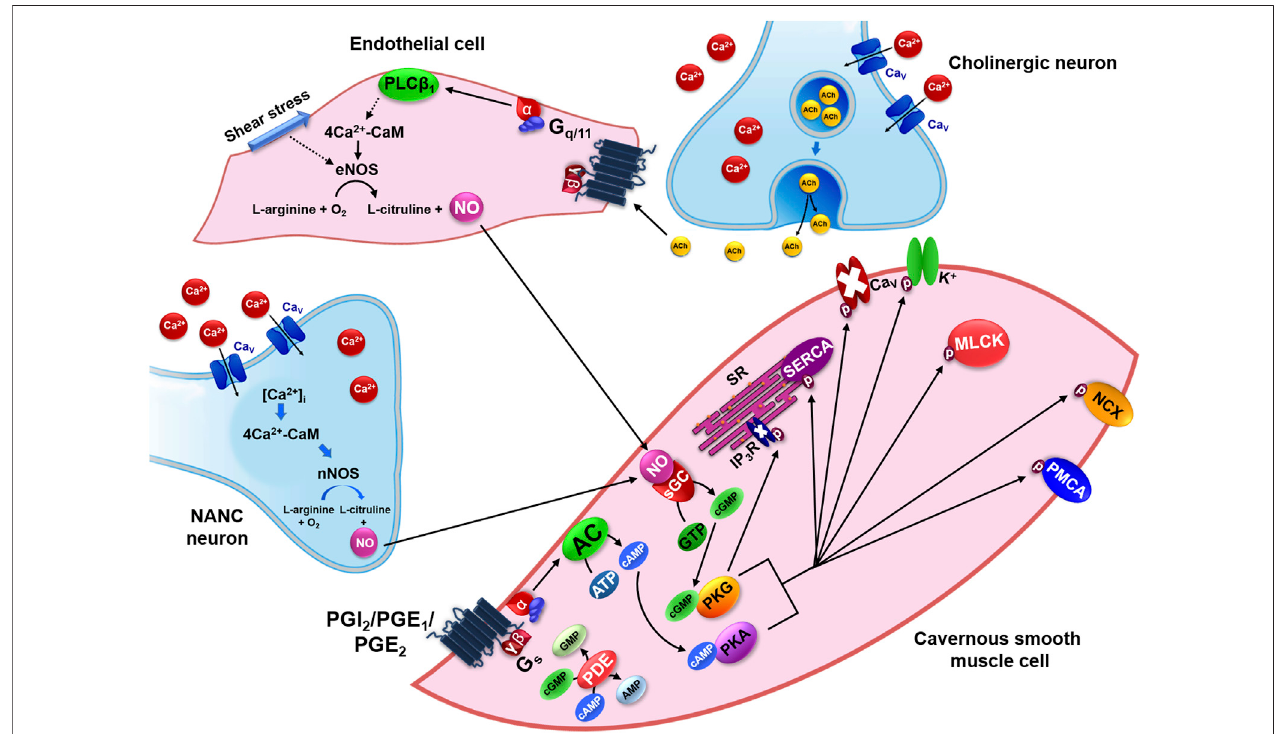
FIGURE 4 | Pharmacomechanical mechanism of relaxation in the cavernous smooth muscle by activation of NO-sGC-PKG and G s -AC-PKA pathways. NANC: non-adrenergic non-cholinergic transmission; [Ca 2+ ] i : intracellular Ca 2+ concentration; CaM: calmodulin protein; nNOS: neuronal nitric oxide synthase; NO: nitric oxide; Ca V :voltage-dependentCa 2+ channels;eNOS: endothelialnitricoxidesynthase; PGI 2 :prostacyclin;PGE 1/2 :prostaglandinsEtypes 1and2;AC:adenylylcyclase; ATP: adenosine triphosphate; cAMP: cyclic adenosine monophosphate; PKA: cAMP-dependent protein kinase; AMP: adenosine monophosphate; sGC: soluble guanylyl cyclase receptor; GTP: guanosine triphosphate; cGMP: cyclic guanosine monophosphate; PKG: cGMP-dependent protein kinase; GMP: guanosine monophosphate; IP 3 : inositol 1,4,5-trisphosphate; SR: sarcoplasmic reticulum; SERCA: Ca 2+ -ATPase of sarcoplasmic reticulum; Ca V : voltage-dependent Ca 2+ channels; MLCK: myosin light chain kinase; NCX: Na + /Ca 2+ exchanger; PMCA: Ca 2+ -ATPase of plasma membrane; PDE: phosphodiesterase